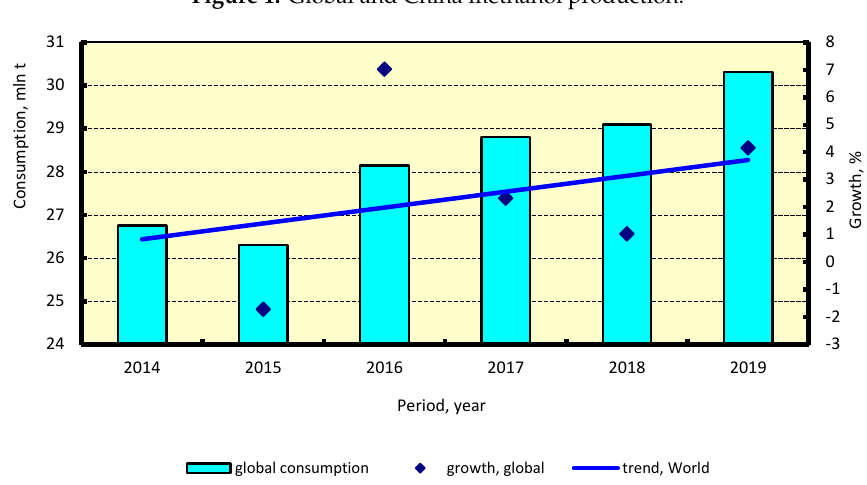
Figure 2. Global methanol consumption as fuel.